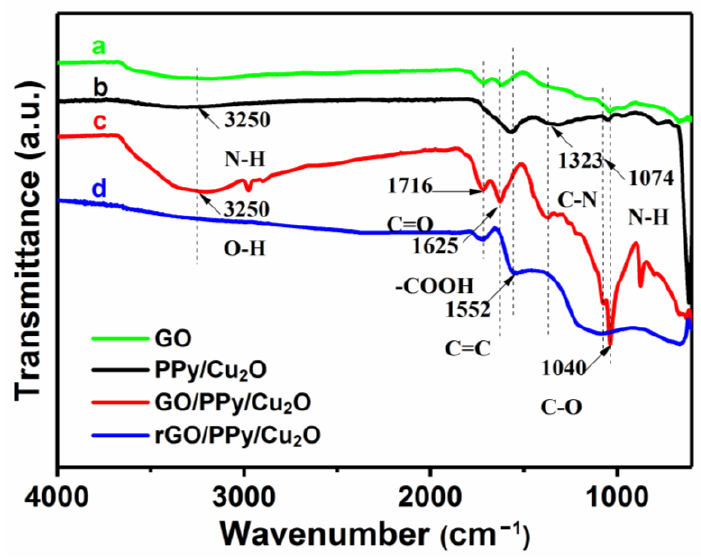
Figure 7. FTIR spectra of (a) GO, (b) PPy-coated Cu 2 O nanowires, (c) GO/PPy/Cu 2 O and (d) rGO/PPy/Cu 2 O nanocomposites.